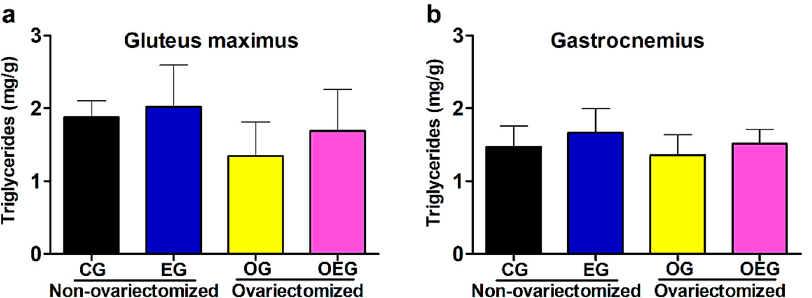
Figure 3. Data from muscular triglyceride of the gluteus maximus ( a ) and gastrocnemius ( b ) in the control group (CG; n = 10), ovariectomized group (OG; n = 10), exercised group (EG; n = 9) and ovariectomized and exercised group (OEG; n = 9). Values expressed as mean and standard deviation. mg: milligrams; g: grams.